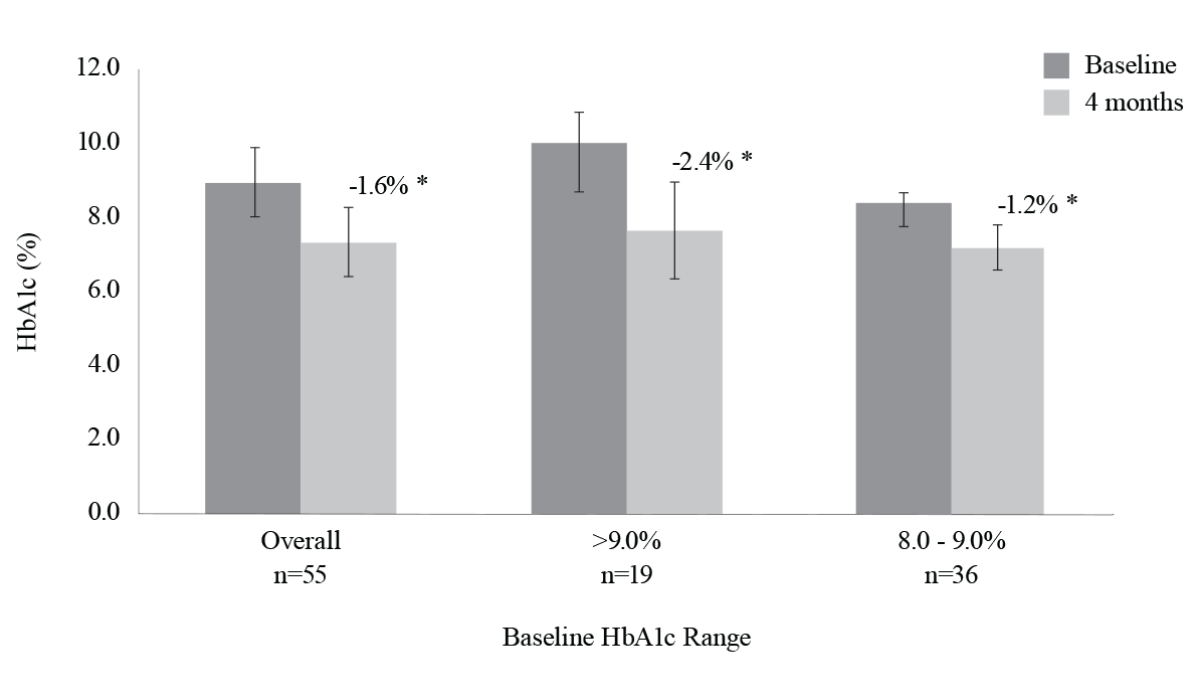
Figure 1. Change in HbA1c at 4 months from baseline. * P <.001.